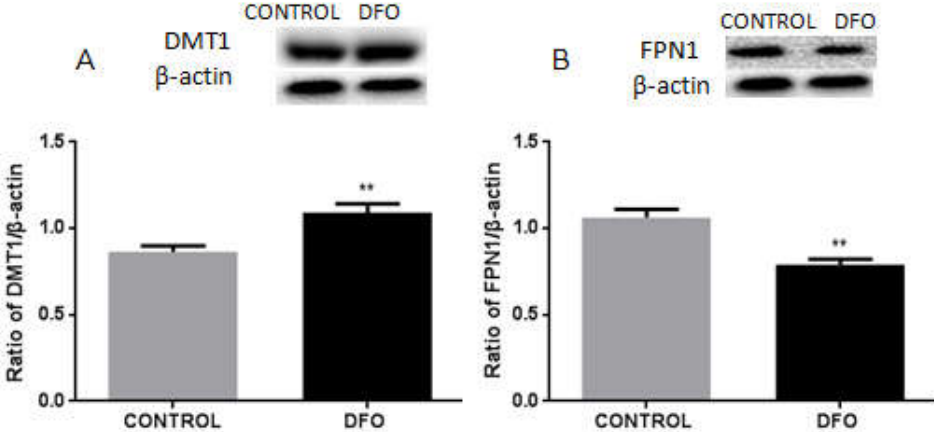
Figure 8. Protein levels of DMT1 and FPN1 DFO-treated BV2 cells. ( A ) Western blot analysis of DMT1 protein levels. DMT1 levels were increased in 100 µ M of DFO treated-BV2 cells. β -actin was used as the loading control. Data are presented as the ratio of DMT1 to β -actin levels. ( B ) Western blot analysis of FPN1 protein levels. FPN1 levels were decreased in 100 µ M of DFO treated-BV2 cells. β -actin was used as the loading control. Data are presented as the ratio of FPN1 to β -actin levels. Each bar represents the mean ± SEM from six independent experiments. n = 6. ** p < 0.01, compared with the control group.